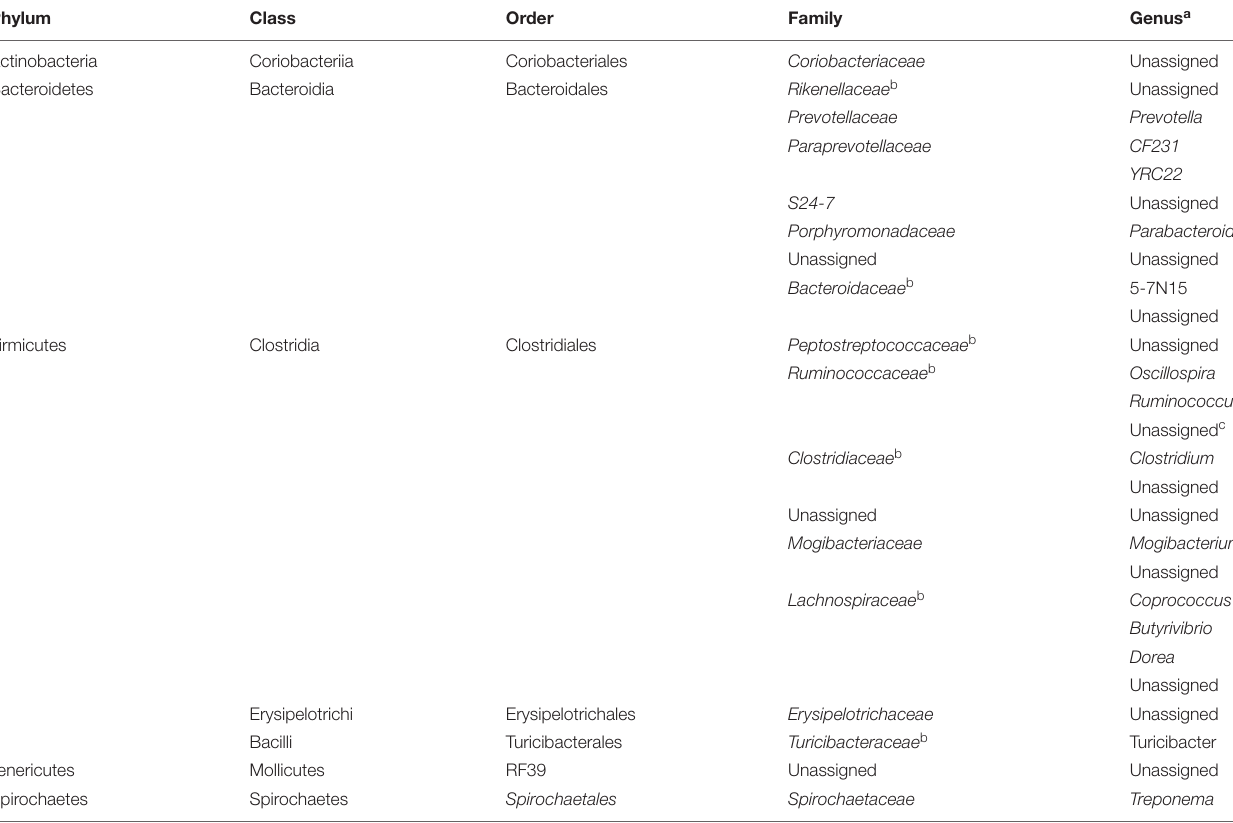
TABLE 2 | Core fecal microbiota of commercial dairy cattle in